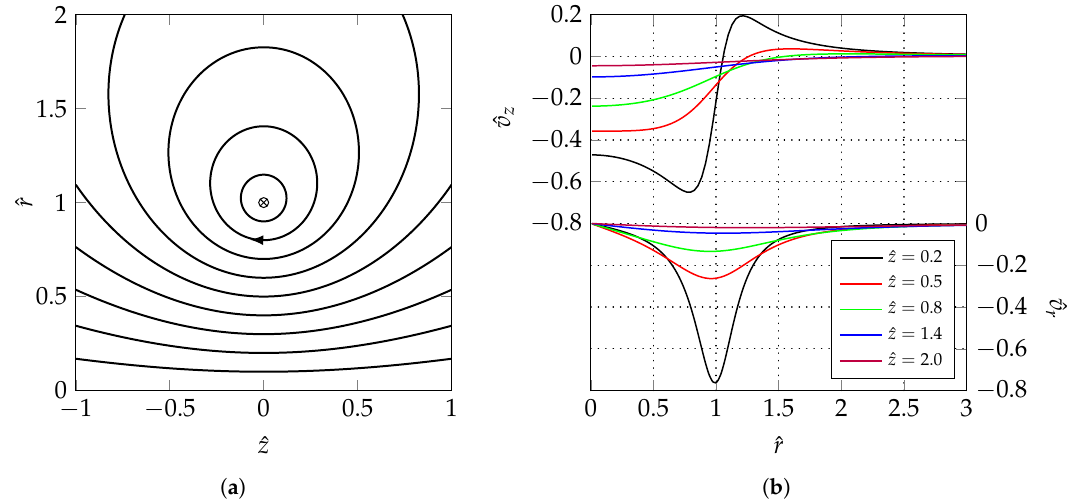
Figure 4. Flow field induced by a ring vortex with unity strength, center in ˆ z = 0 and unity radius. ( a ): streamlines. ( b ): axial and radial velocity distributions at different axial